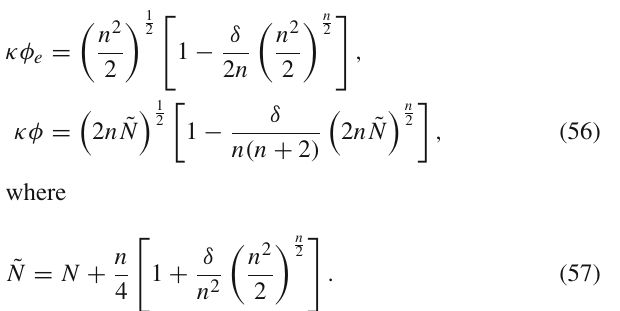
Fig. 1 Observational constraints on chaotic inflation with n = 2 in Eq. (50). The parameter increases from the red to blue points and ranges between 0 ≤ δ < δ max , where δ max (cid:9) 3 . 5727 × 10 − 2 , 3 . 0094 × 10 − 2 , and 2 . 6008 × 10 − 2 for N = 50 (dotted), 60 (solid), and 70 (dashed) lines, respectively. The background shaded regions indicate the 1 σ (darker) and 2 σ (lighter) contours of the observational data [18]. The inset plot shows a closer look on the N = 60 solid line